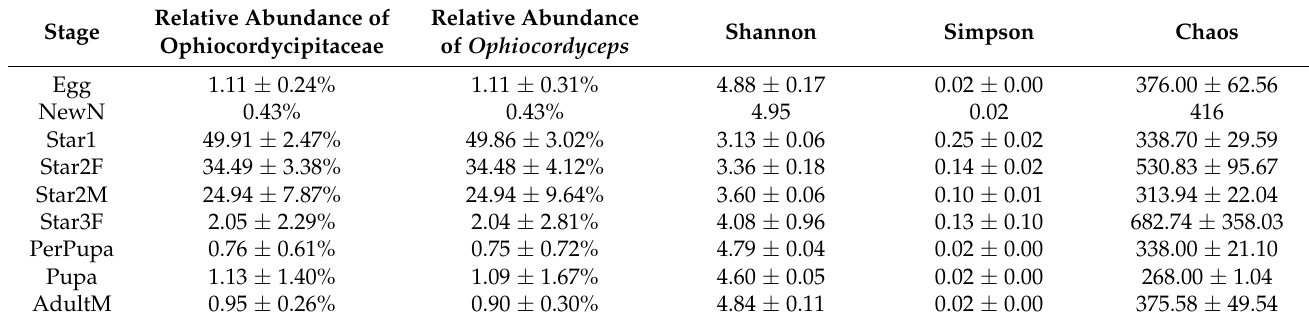
Figure 6. Relative abundance of fungi at family level ( A ) and genus level ( B ) in Ceroplastes japonicus at nine developmental stages, including the egg, newly hatched nymph (newN), first instar nymph (star1), second instar female nymph (star2F), second instar male nymph (star2M), third instar female nymph (star3F), prepupa, pupa, and male adult (adultM). Table 1. The fungal alpha diversity and relative abundance of Ophiocordycipitaceae in Ceroplastes japonicus at different developmental stages (mean ± SD).